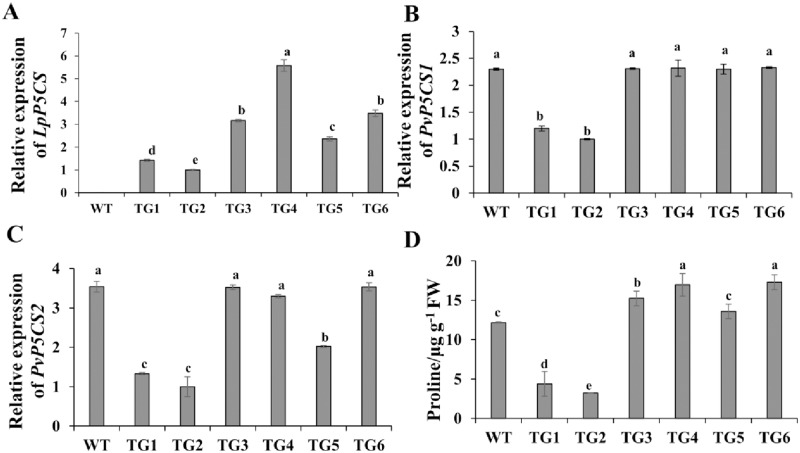
Molecular analysis of transgenic switchgrass lines overexpressing LpP5CS.(A) Relative expression levels of LpP5CS (TG2 was used as a control), (B) PvP5CS1 and (C) PvP5CS2 in transgenic and WT plants. (D) Proline content in transgenic plants. Switchgrass Ubq1 was used as the reference for normalization, the relative expression levels of genes were calculated using 2−ΔΔCT method, and the expression level of one plant (control) was defined “1”. Value are mean ± SE (n = 6). The significance of treatments was tested at the P < 0.05 level (one way ANOVA, Dunnett’s test).